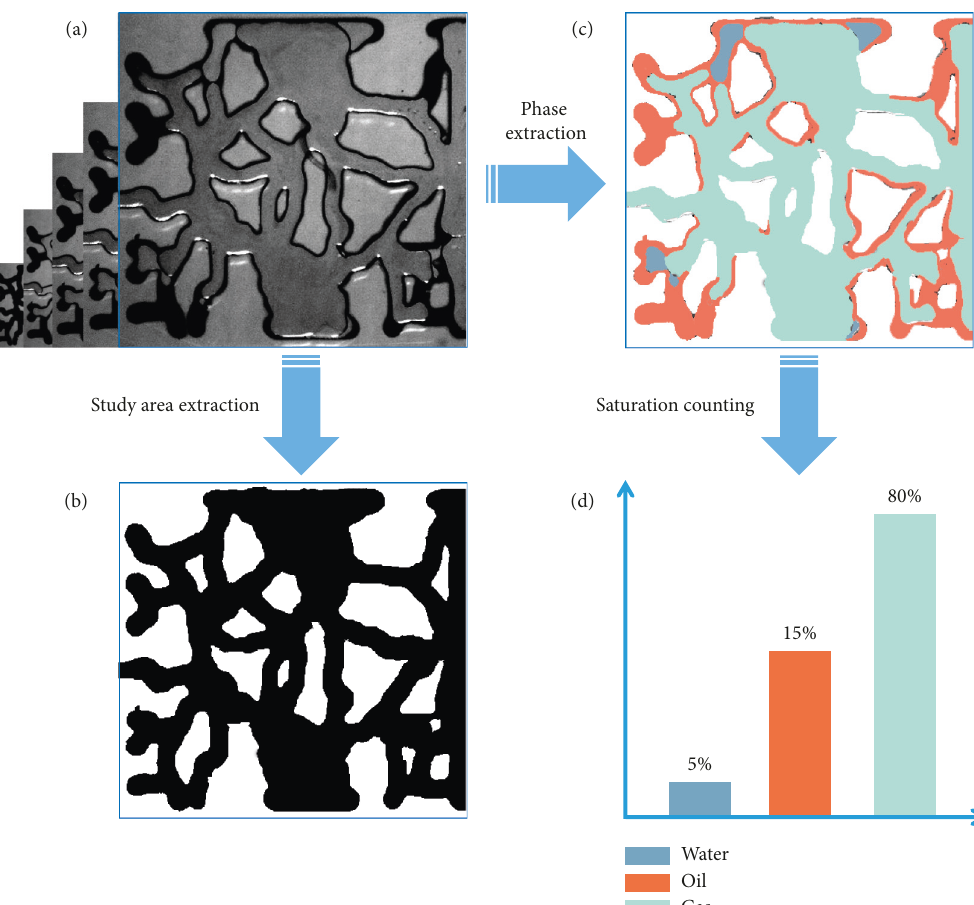
Figure 5: Saturation extracted and TSD obtained from experimental images based on image recognition algorithm.